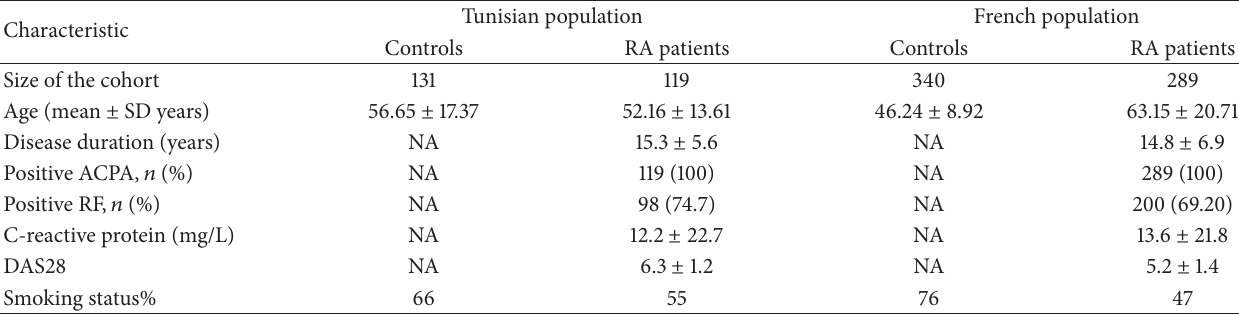
Table 1: Characteristics of female samples from Tunisian and French cohort.